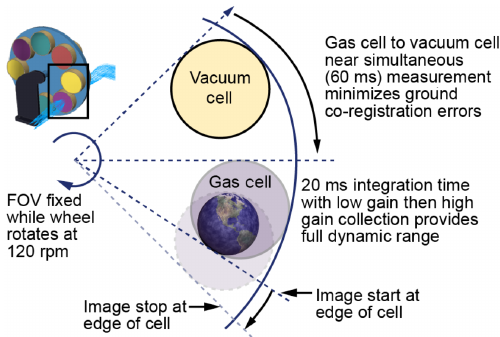
Figure 10. CHRONOS’ eight gas cells are mounted in a continu- ously spinning mechanism wherein each cell in sequence exposes an unobscured Earth FOV as defined in Fig. 8. A single-frame im- age is collected with a prescribed integration time. Single frames are continuously collected and downlinked via the host spacecraft. In ground processing the ensemble of single frames are co-added to achieve the required signal-to-noise ratios for each